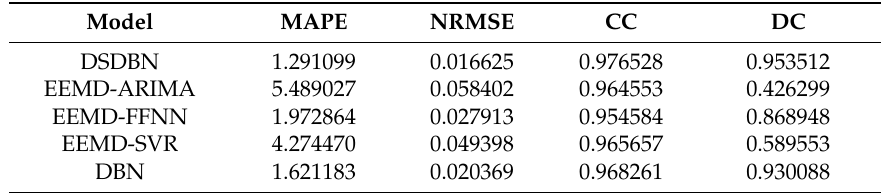
Table 2. Comparison of the predictive performances by using different forecasting